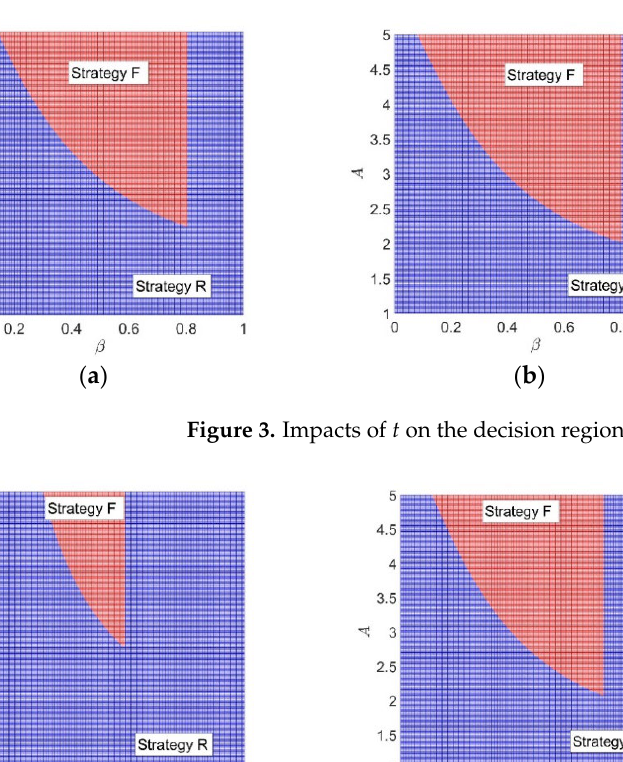
on the decision region when 𝛿𝛿